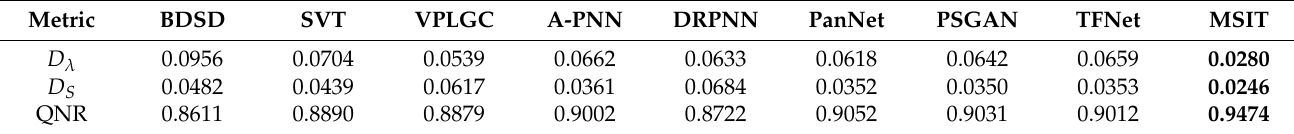
Table 4. Numerical evaluations of the fused images in Figure 7 (GeoEye-1